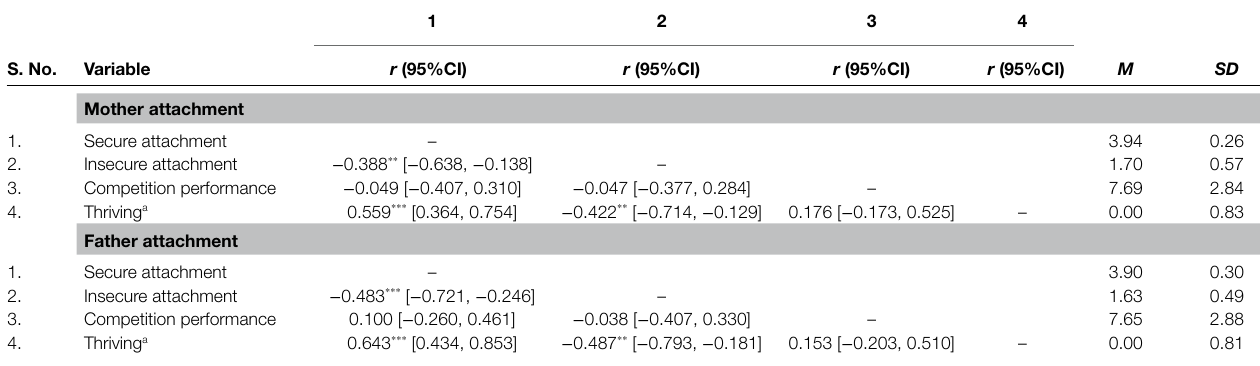
TABLE 2 | Descriptive statistics and correlations for secure attachment, insecure attachment, competition performance, and thriving.